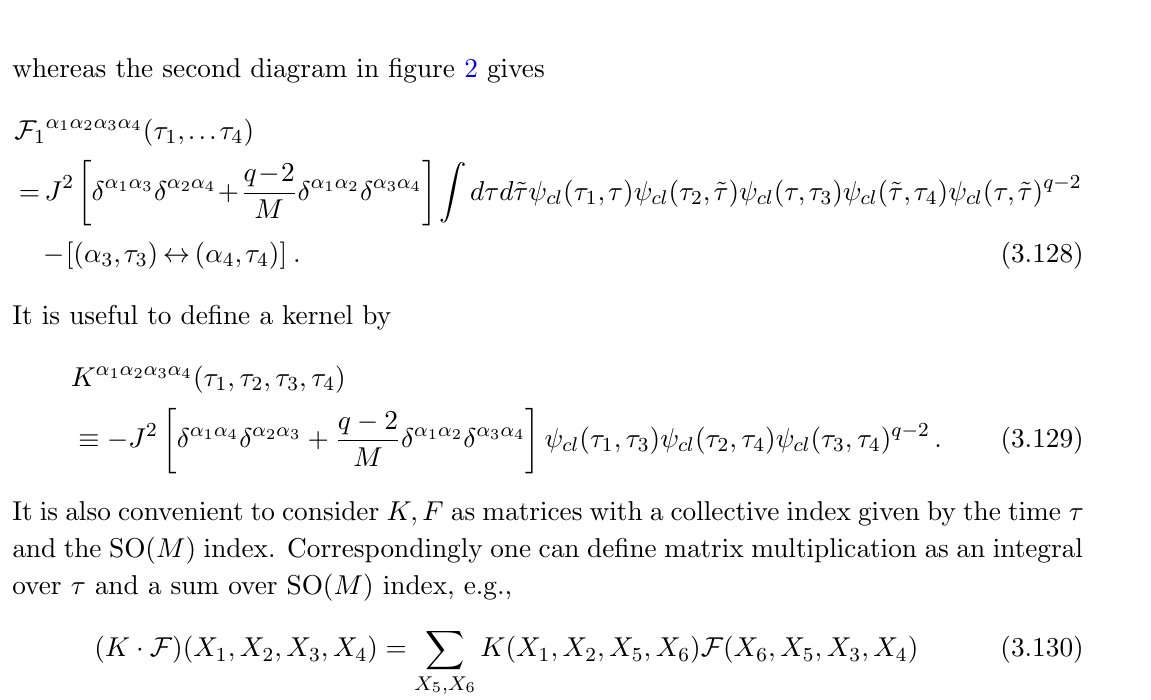
Figure 2. Ladder diagrams. There are also diagrams with ( (cid:11) 3 ; (cid:28) 3 ) $ ( (cid:11) 4 ; (cid:28) 4 ) with a relative minus